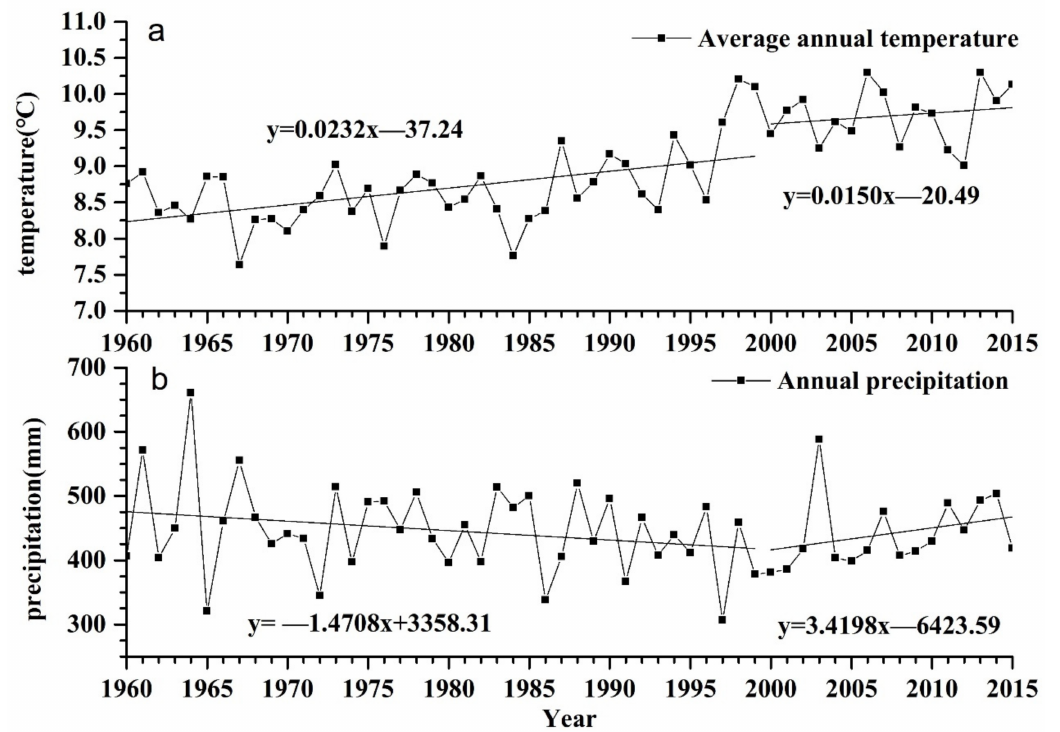
Figure 10. Annual precipitation ( b ) and average temperature ( a ) changes on the Loess Plateau from 1960 to 2015.